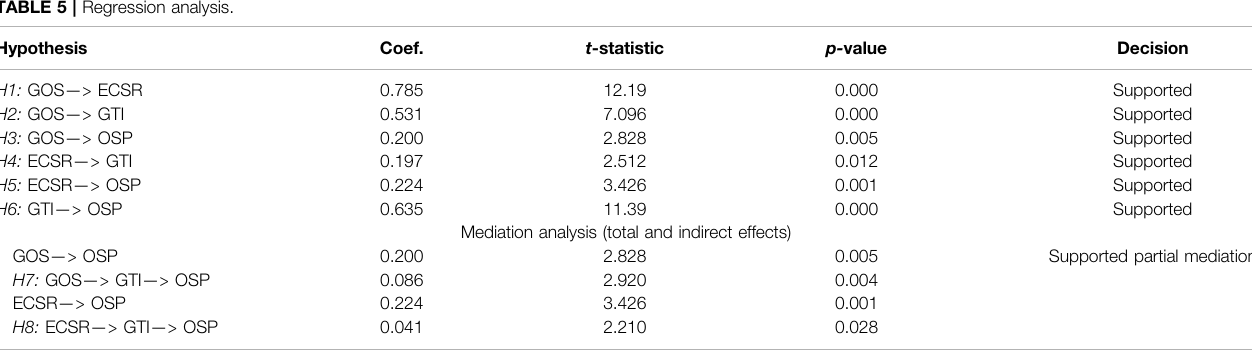
TABLE 5 | Regression